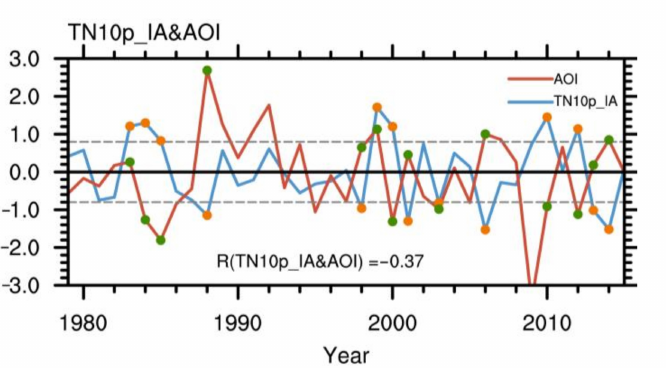
Figure 9. Standardized IA component of TN10p (TN10P_IA, blue line) and AO index (AOI, red line). The gray dashed lines represent ± 0.8 standard deviation. The solid orange (green) dots denote the positive or negative years of TN10P_IA (AOI) above 0.8 or below − 0.8 standard deviation.